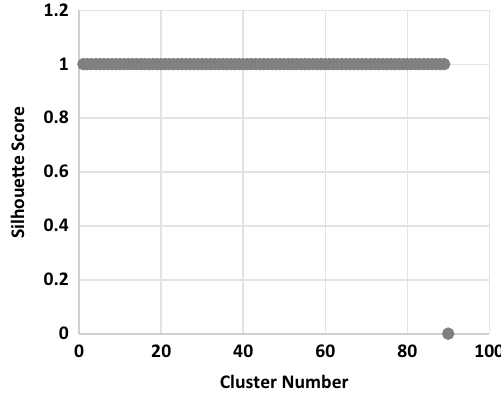
Fig. 12 Silhouette score of 90